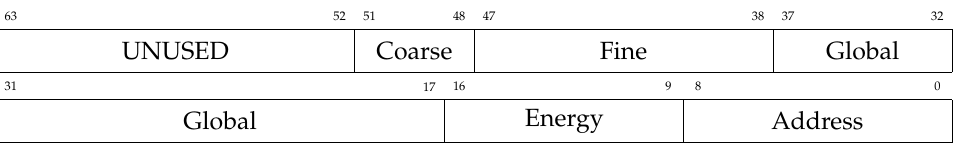
Figure 5. Dataframe of the the base output mode. Address [9 bits]: Address of the pixel. Energy [8 bits]: Number of hits received by that pixel since the last readout. Global [21 bits]: Timestamp of the system clock (250 MHz). Fine [10 bits]: TDC fine counter value. Coarse [4 bits]: TDC coarse counter value.